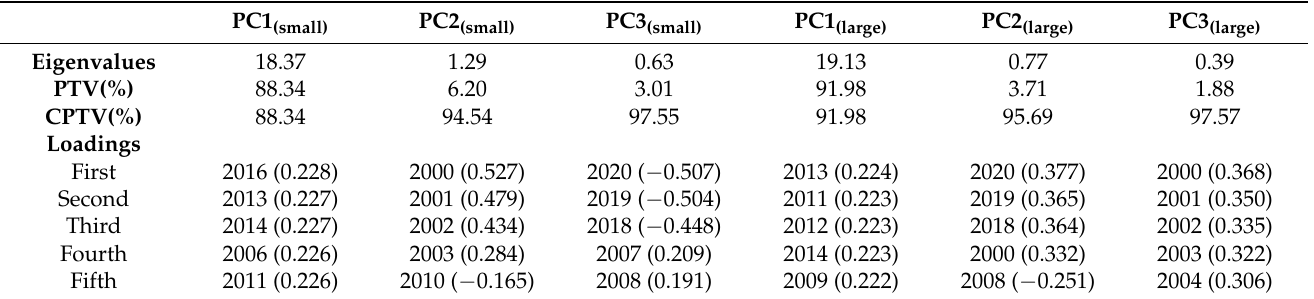
Table 1. Eigenvalues, PTV, CPTV and Loadings for the global principal component analysis